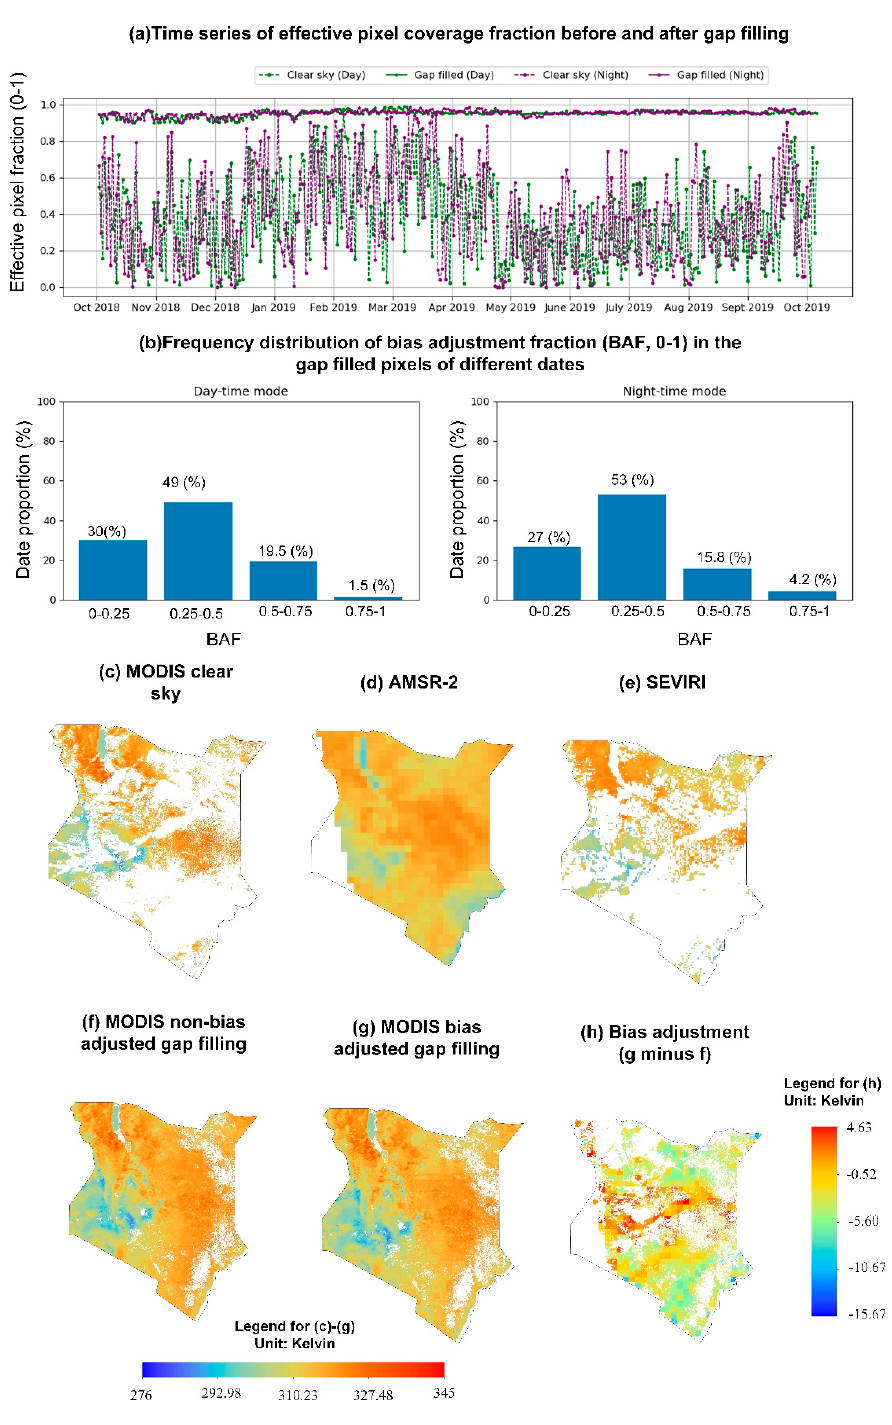
Figure 4. Demonstration of the cloud gap filling approach for the Aqua MODIS LST data record. ( a ) Time series of LST fractional coverage of Kenya before and after gap-filling. ( b ) Proportional distribution of bias adjustment fraction (0–1) in the gap filled pixels of different dates. ( c – e ) Daytime LST maps from the different spaceborne sensors recoded near simultaneously on 22 October 2018, and ( f , g ) the MODIS LST data of ( c ) now cloud gap-filled using the methodology detailed herein. All MODIS LST pixels with an NDVI of < − 0.2 (indicating the likely presence of surface water) have been screened out in these latter two datasets. ( h ) A bias adjustment map of cloud gap-filled LST (clear sky pixels eliminated) generated by ( g ) minus ( f ).